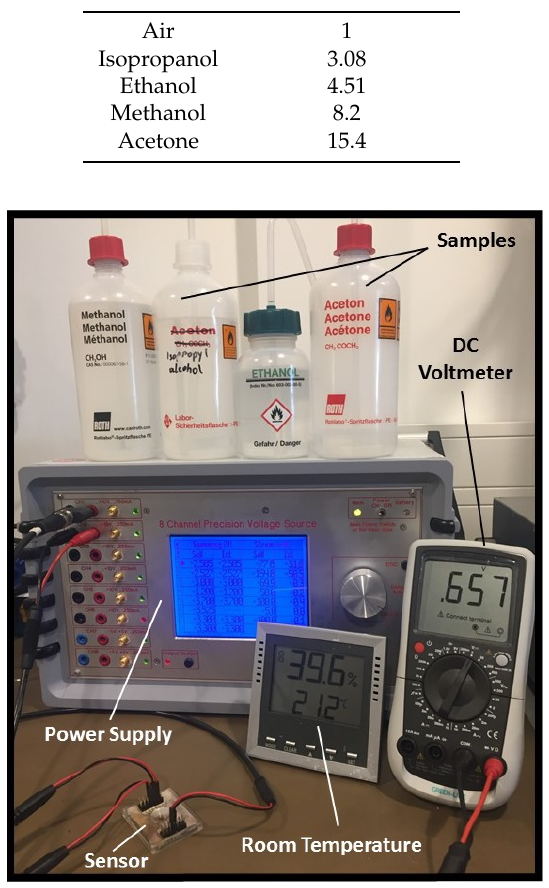
Figure 5. Measurement setup for the sensor calibration and validation